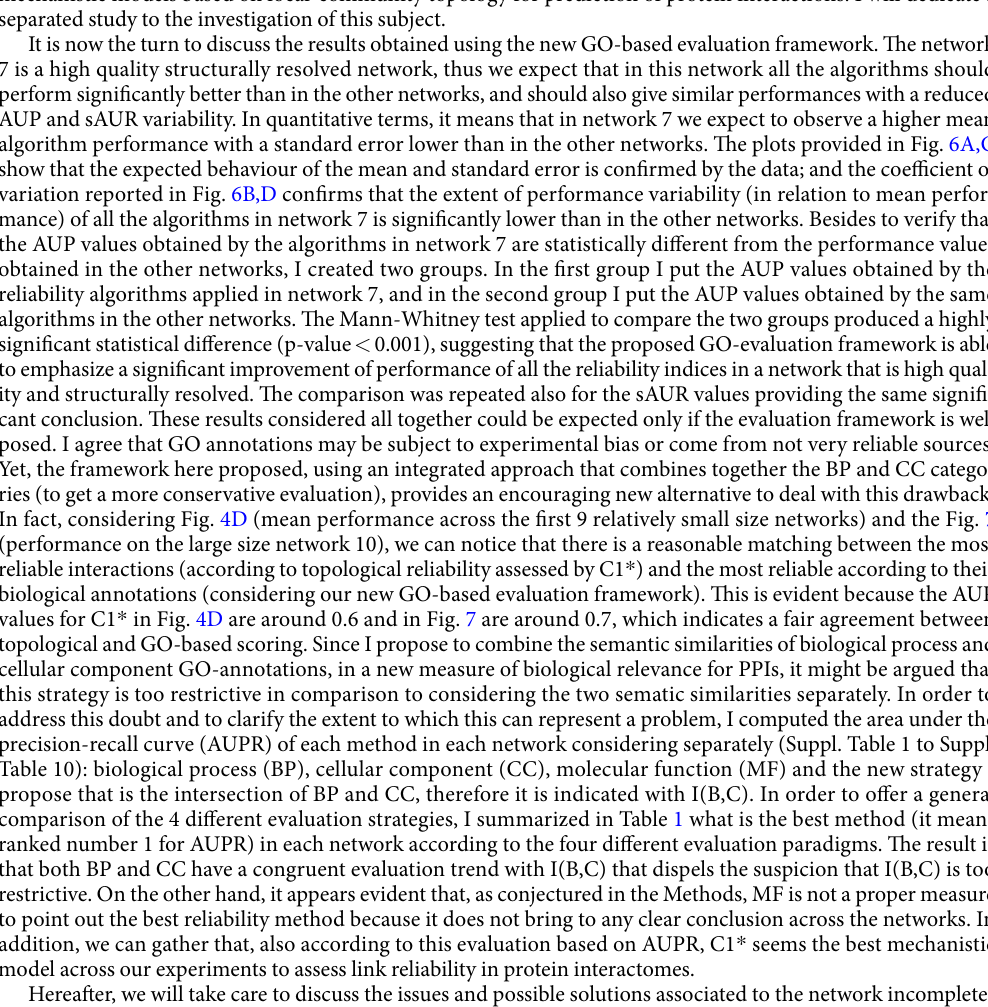
Table 10): biological process (BP), cellular component (CC), molecular function (MF) and the new strategy I propose that is the intersection of BP and CC, therefore it is indicated with I(B,C). In order to offer a general